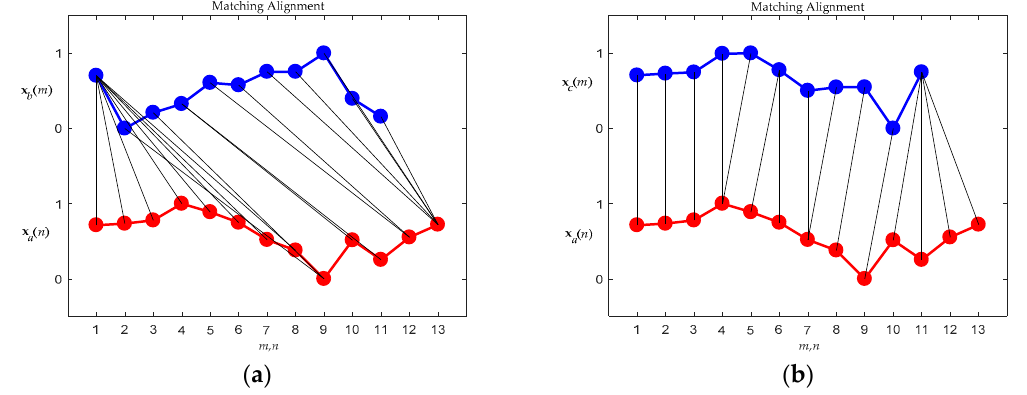
Figure 9. Matching alignments. ( a ) Between x a and x b ; ( b ) Between x a and x c .